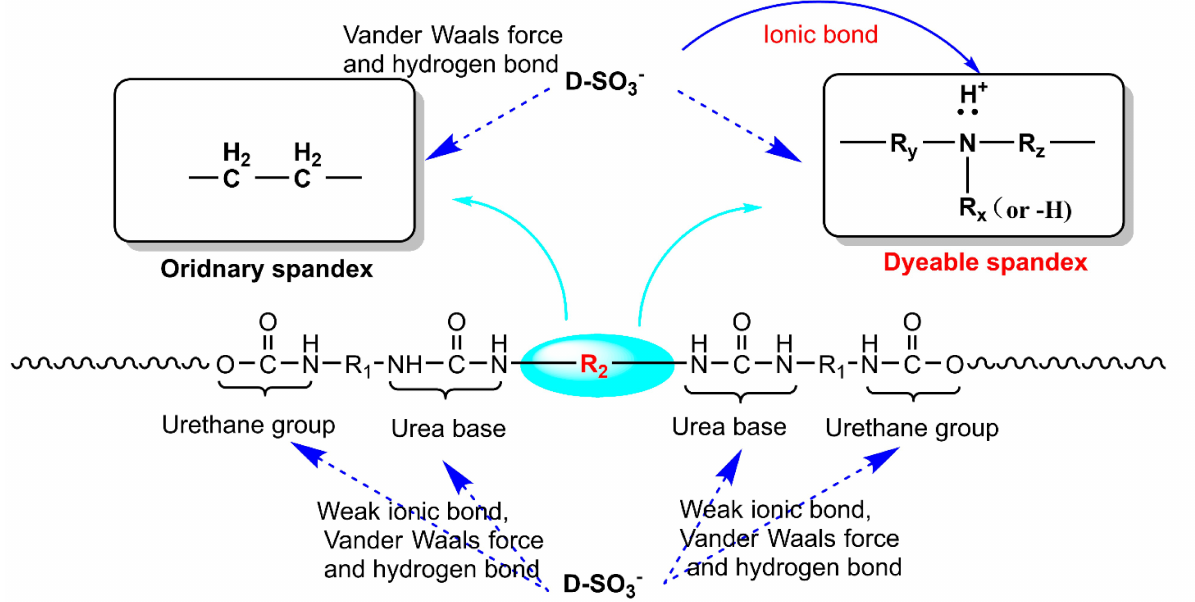
Figure 17. Adsorption mechanism of neutral red G on